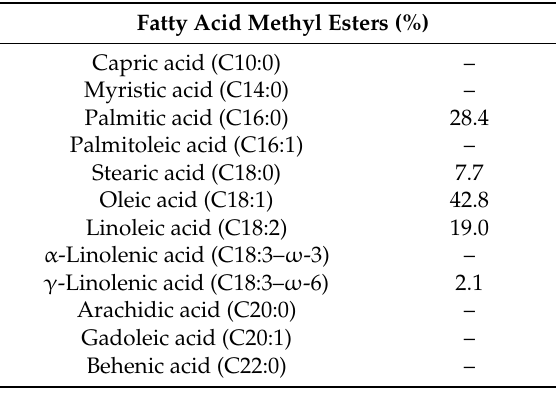
Table 4. Fatty acid profile of total lipids from biomass of Candida lipolytica in Assay 4 after 96